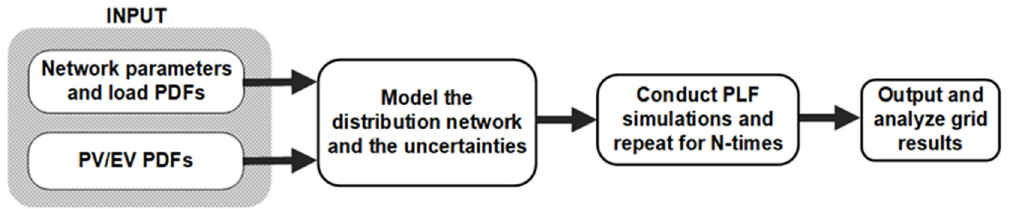
Figure 5. Stochastic method illustration.